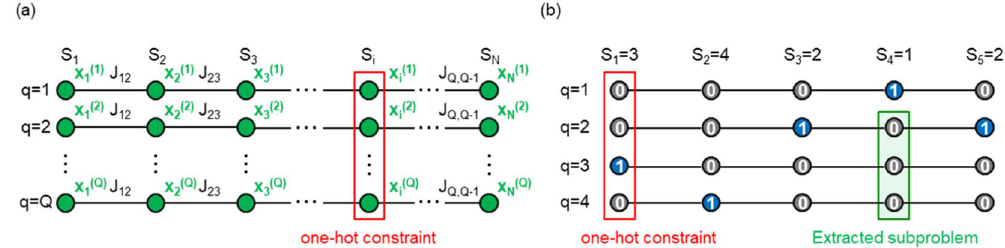
Figure 1. ( a ) Problem graph of Eq. (7). Vertices and edges represent binary variables x between them, respectively. Although the penalty term generates fully connected vertical interactions between x i q ( ) and x i q ( ) ′ , these are not shown for simplicity. Q binary variables